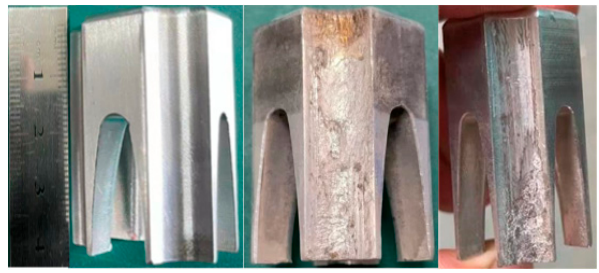
Figure 19. Armature recovered after launch.